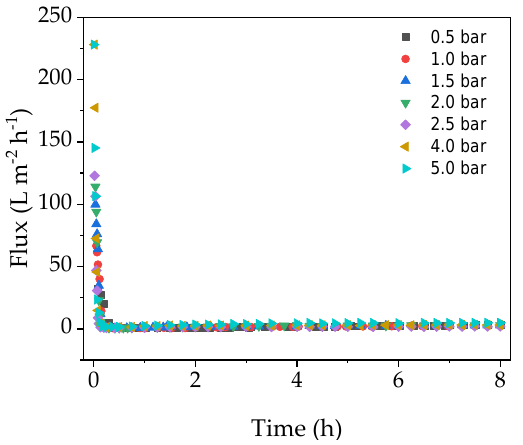
Figure 2. Flux curves for catalysis experiments at different transmembrane pressures (TMPs) (constant 70 °C, cross-flow velocity (CFV) = 0.5 m s − 1 ).